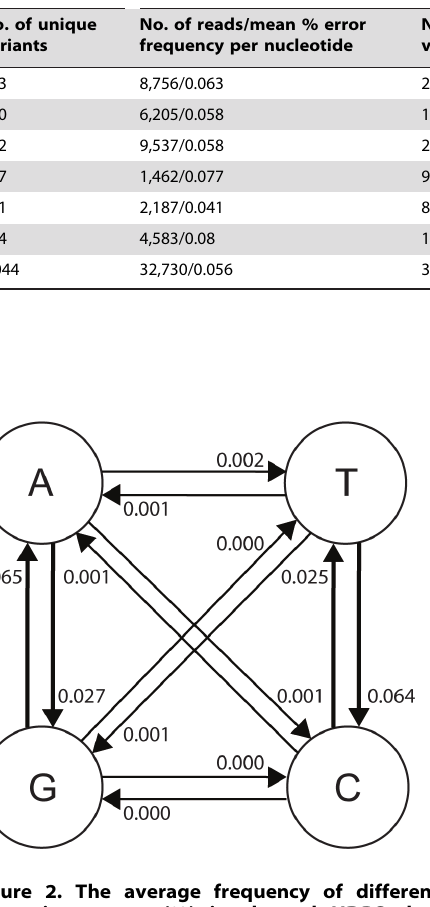
Figure 2. The average frequency of different substitution errors in percent (%) in cleaned UDPS data from three sequencing runs. Thick arrows indicate transitions and thin arrows indicate